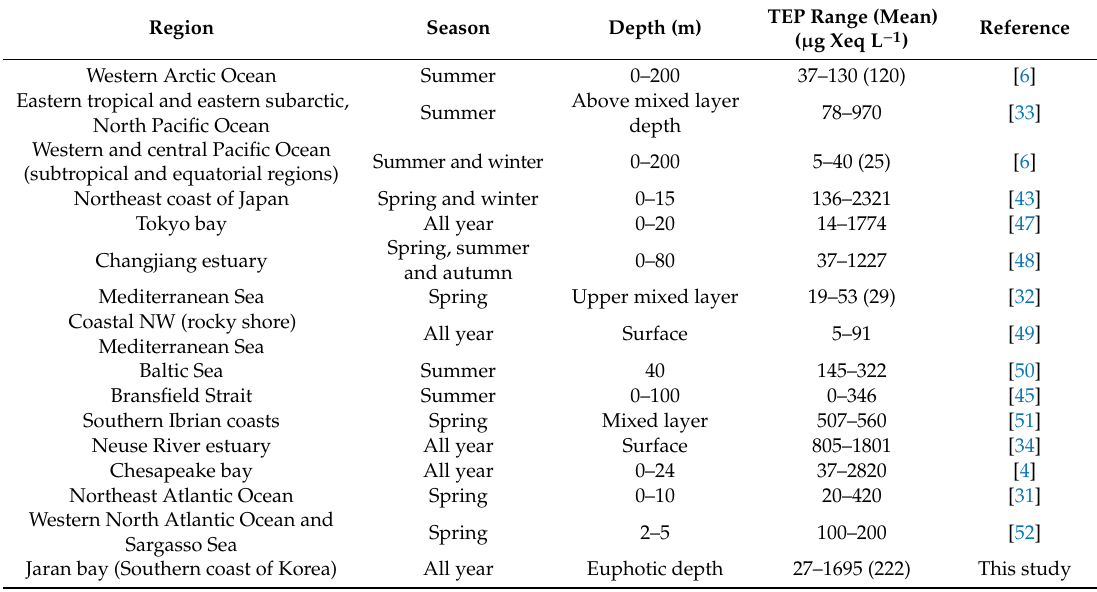
Table 3. Comparison of the TEP concentrations between this and previous studies from various